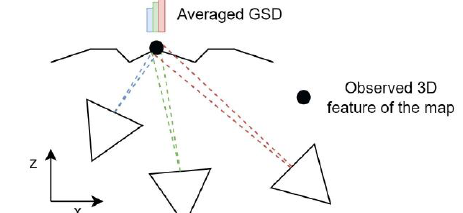
Figure 5 . Principle of the average GSD used in GuPho and colour schema with red points too far, green within the proper distance range and blue too close (Torresani,